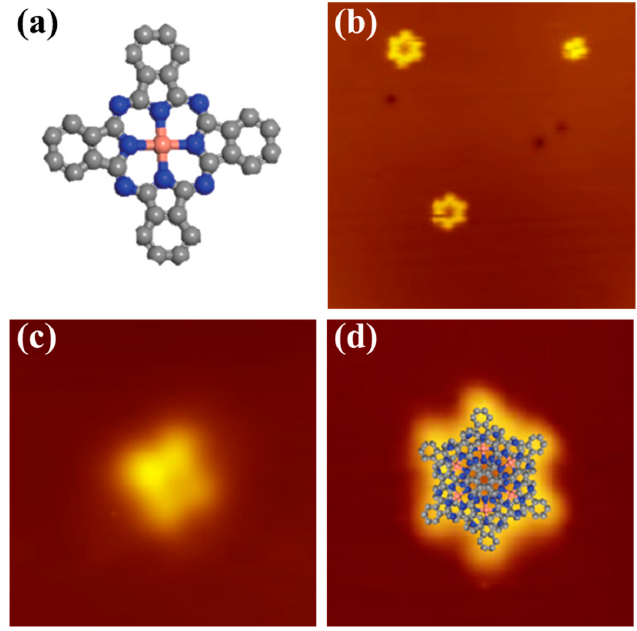
Figure 1. ( a ) Schematic structure model of the CuPc molecule; ( b ) STM image of isolated CuPc molecules in stationary and rotational state at 78 K, 25 × 25 nm, − 2.0 V, 28 pA; ( c ) High-resolution STM image of a stationary CuPc molecule, 5 × 5 nm, − 1.0 V, 26 pA; ( d ) High-resolution STM image of a rotating CuPc molecule, 5 × 5 nm, − 2.8 V, 28 pA. The structural model for the six stable orientations of CuPc molecules are superposed on the STM image.